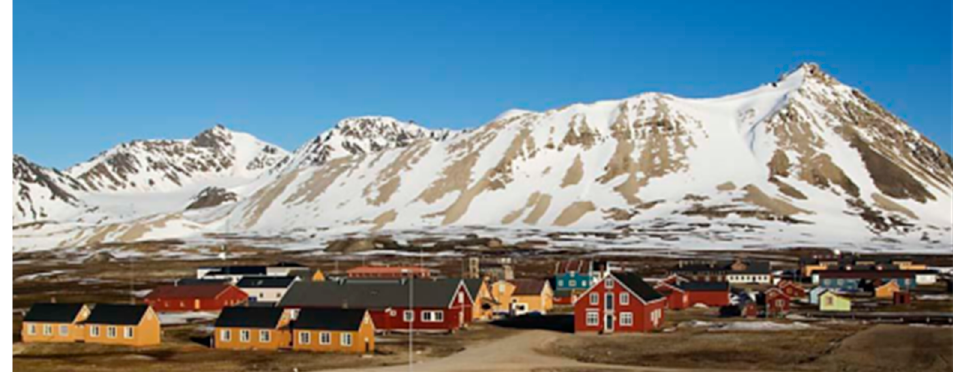
Figure 2. The world’s northernmost scientific research town. Airscape at Ny-Ålesund (from Kings Bay AS).